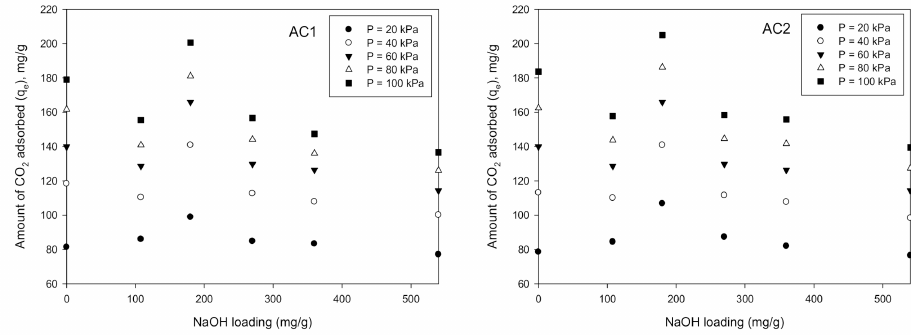
Figure 11. Effect of NaOH loading on the amount of CO 2 adsorbed by coconut shell activated carbon (AC1 and AC2) at various